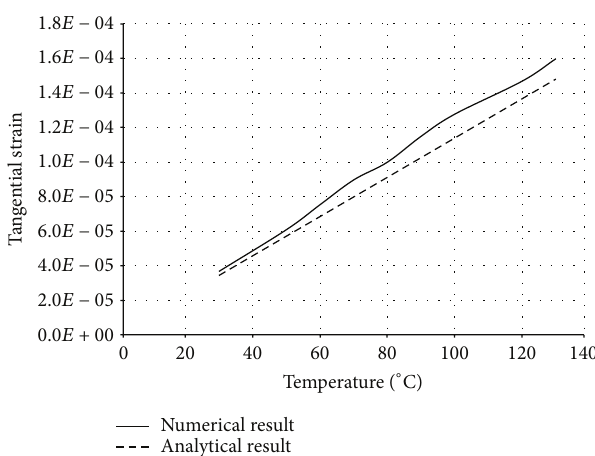
Figure 17: Comparison of axial stress in concrete.